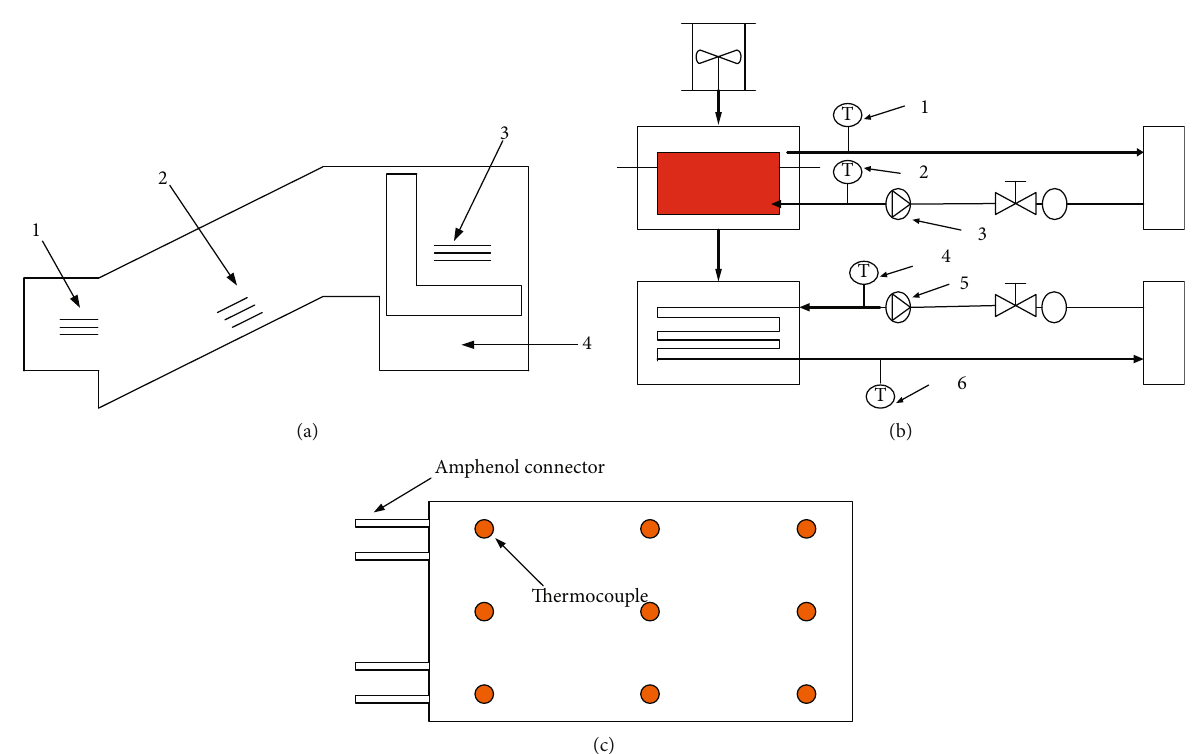
Figure 5: Measuring locations of main parameters in this study: (a) temperature and relative humanity measurement points in 1 — the ambient air inlet, 2 — the evaporation chamber, 3 — the condensation chamber, and 4 — the freshwater generate section; (b) measurement location of 1 — the brine outlet temperature, 2 — the brine inlet temperature, 3 — the brine fl ow rate, 4 — the cooling water inlet temperature, 5 — the cooling water fl ow rate, and 6 — the cooling water outlet temperature; (c) the thermocouple locations at the surface of the heating plate to measure the brine fi rm